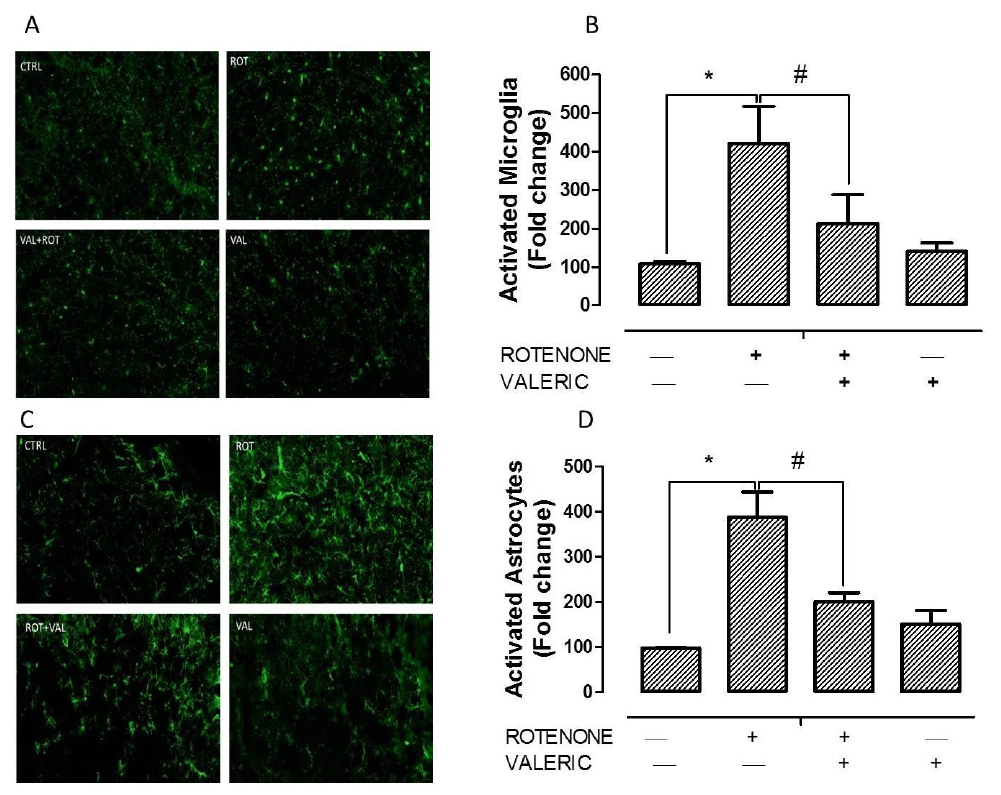
Figure 3. Valeric acid attenuated microglia and astrocyte activation induced by rotenone. Immunofluorescent staining with Iba-1 ( A ) and GFAP ( C ) of experimental animals. Picture shows 20 µm thick sections of striatum between different groups. Densitometric assessment of fluorescent intensity to quantify microglia ( B ) and astrocyte ( D ) activation. Rotenone administration caused profound increase in Iba-1 positive microglia and GFAP positive astrocyte. Alternatively, Val treatment decreased the activation of microglia and astrocyte as evinced by decrease in Iba-1 and GFAP positive cells. Values are expressed as mean ± SEM. * p < 0.05 compared to control, # p < 0.05 compared to rotenone treated group.